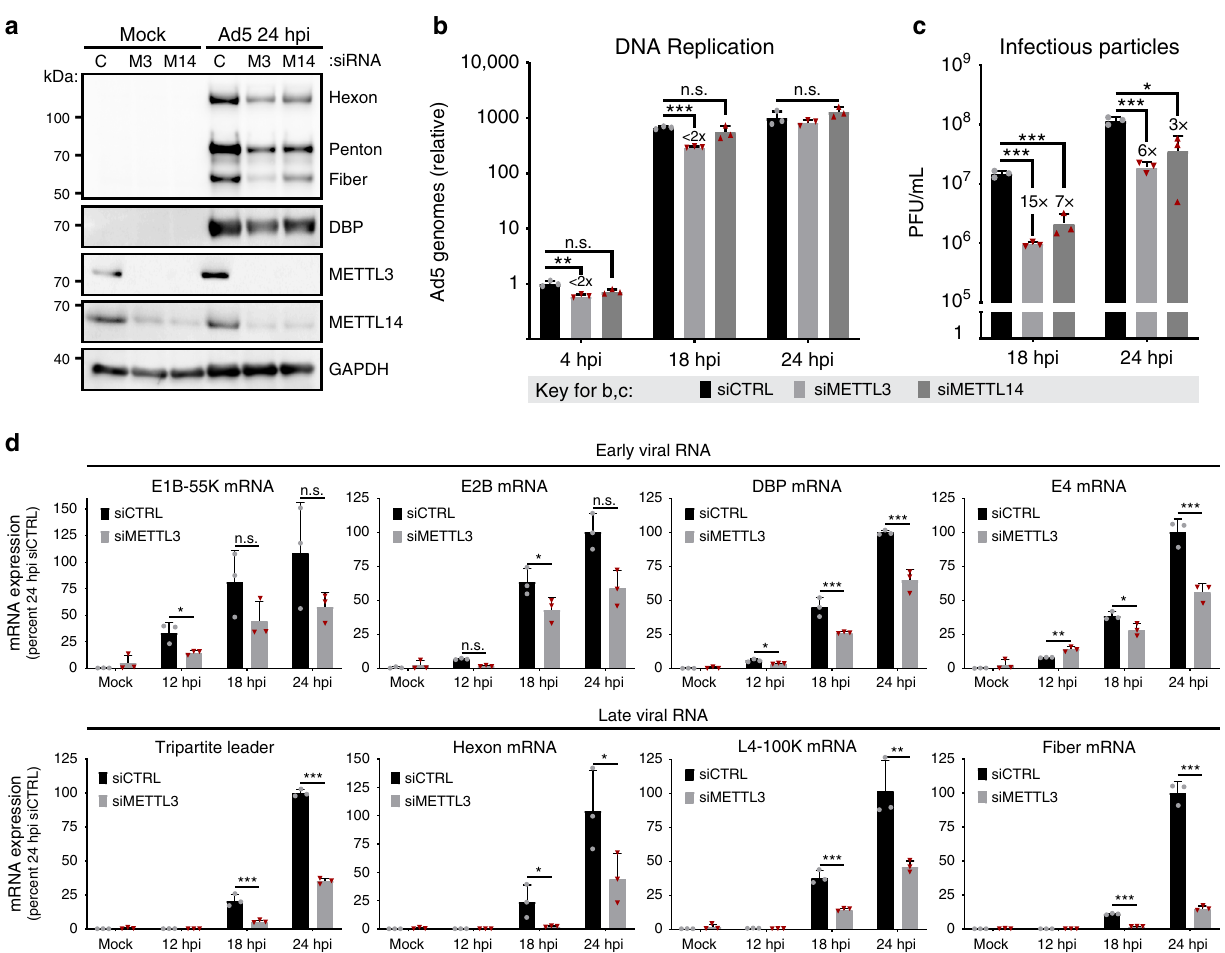
Fig. 5 Loss of METTL3 differentially impacts late viral gene expression. a A549 cells were transfected with control siRNA (C), or siRNA targeting METTL3 (M3) or METTL14 (M14) for 48 h before Ad5 infection. Viral late proteins were analyzed at 24 hpi with polyclonal antibody against structural proteins (Hexon, Penton, and Fiber) or early protein DBP. b Viral DNA replication was measured in biological triplicate samples with qPCR at different times after infecting A549 cells depleted of METTL3 or METTL14 by siRNA. Fold-change in genome copy was normalized to the amount of input DNA at 4 hpi in control siRNA treated cells. c Infectious particle production was measured at different times by plaque assay after infecting A549 cells depleted of METTL3 or METTL14 by siRNA. d Viral RNA expression was measured by qRT-PCR in a time-course of infection after control or METTL3 knockdown for 48 h. Viral early transcripts are shown on the top, while late stage transcripts are shown on the bottom. For all assays signi fi cance was determined by Experiments are representative of three biological replicates and graphs represent mean + / − standard